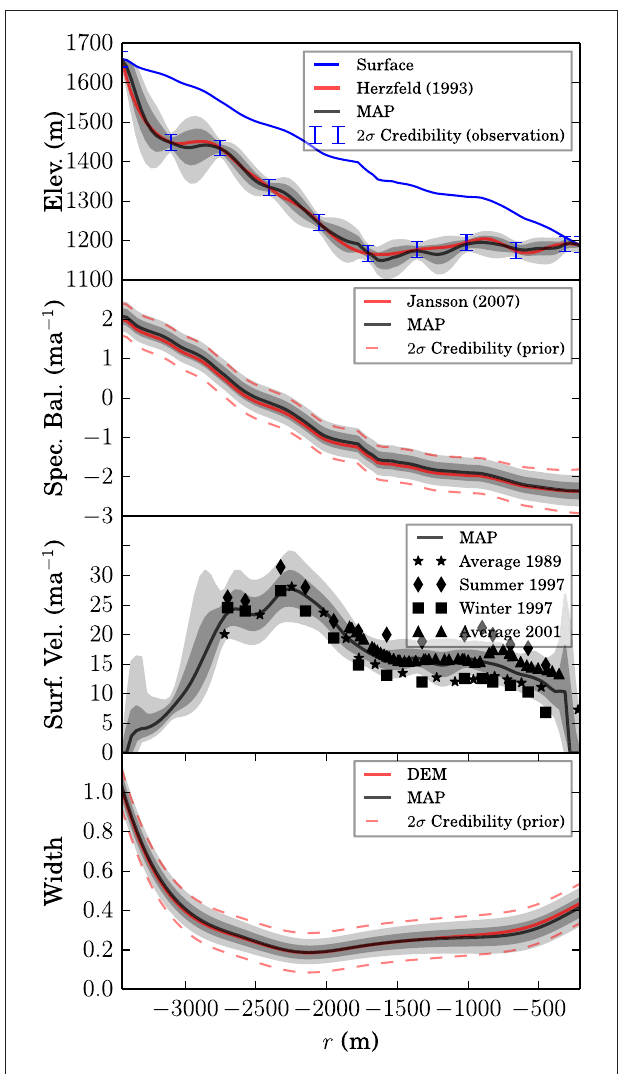
FIGURE 4 | Recovered pointwise probability densities for Storglaciären. Dark and light gray shaded regions indicate the σ and 2 σ posterior credibility interval,